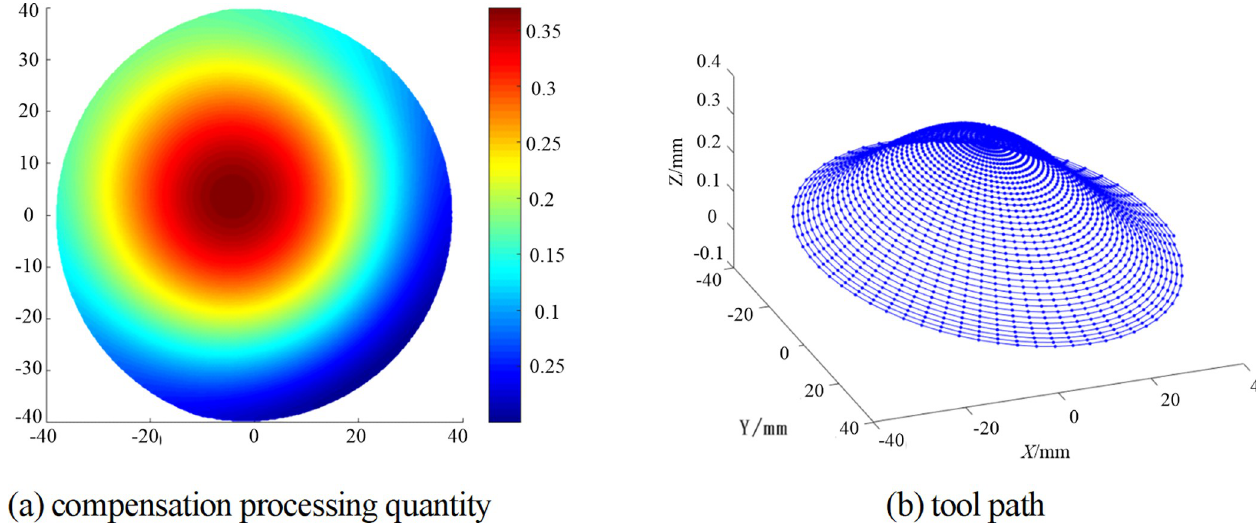
Fig 8. The compensation processing quantity and tool path.